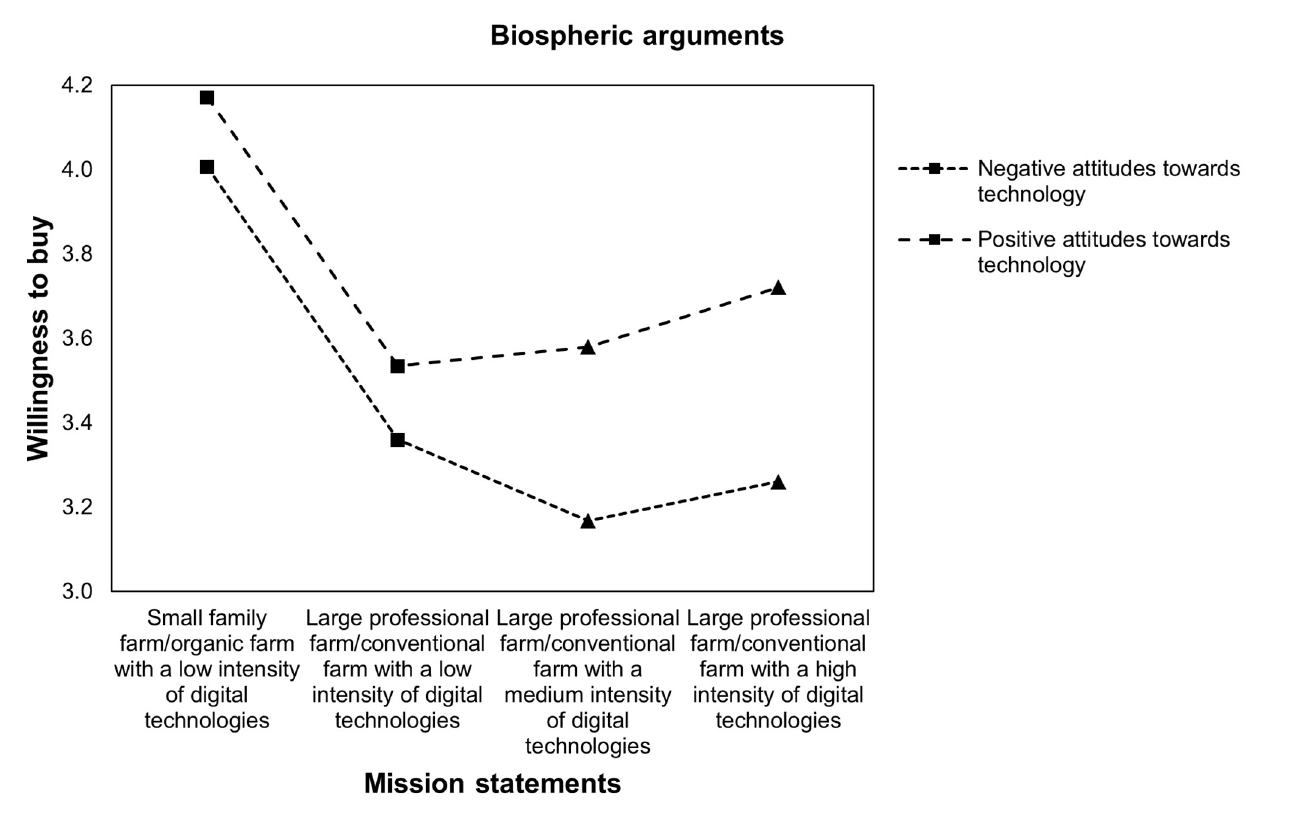
Fig 6. Profile plot of WTB food and attitudes towards technology with biospheric